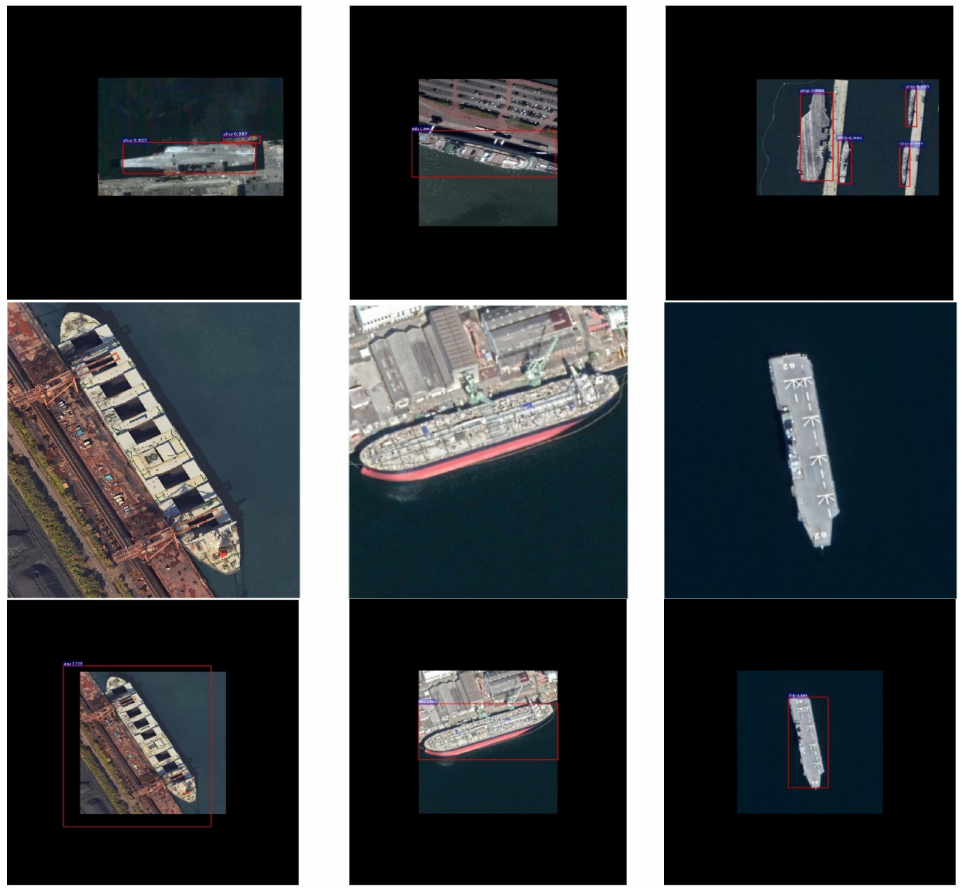
Figure 19. The comparison of the Faster R-CNN and Saliency-Faster R-CNN in the case of the large-scale ships. The first and third rows are results of the Faster R-CNN, and the second and fourth rows are results of the Saliency-Faster R-CNN.